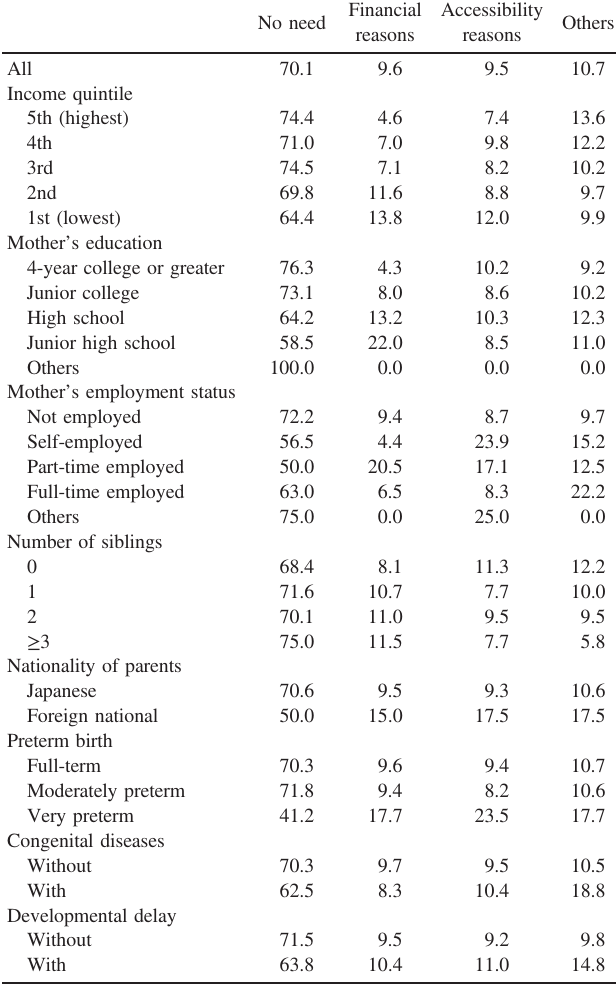
Table 3. Reasons for non-use of center-based childcare in the 2010 cohort Financial No need